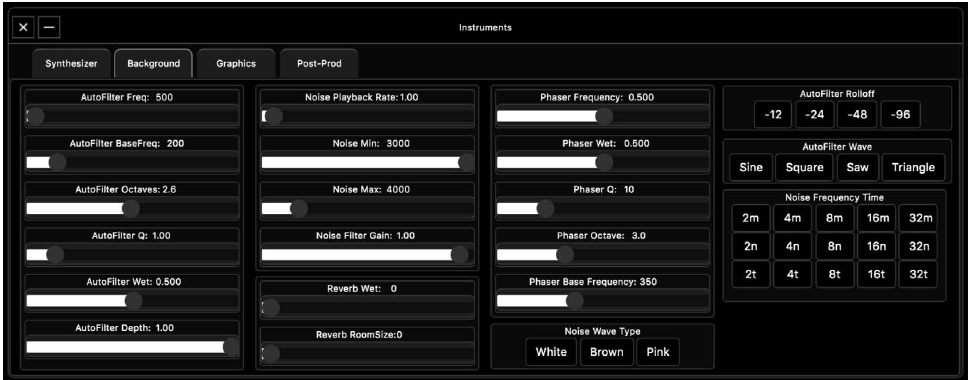
Figure 6: GUI Elements of Akson: 5) Instruments Dialog – Background